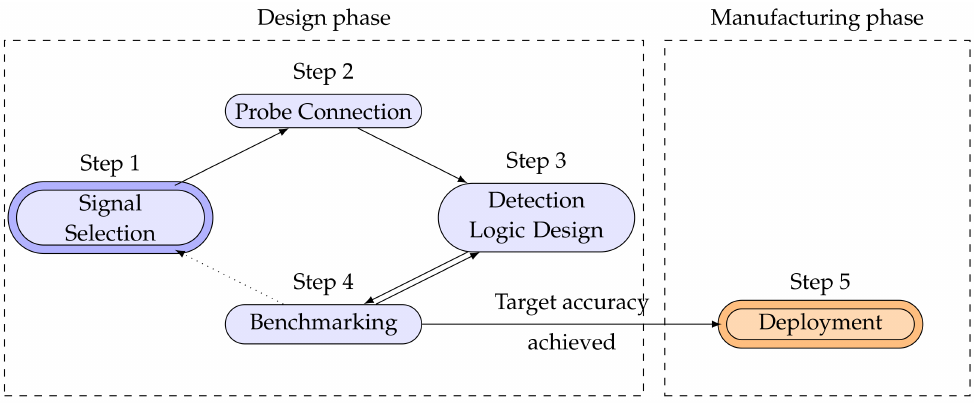
Figure 2. Methodology for attack detection using